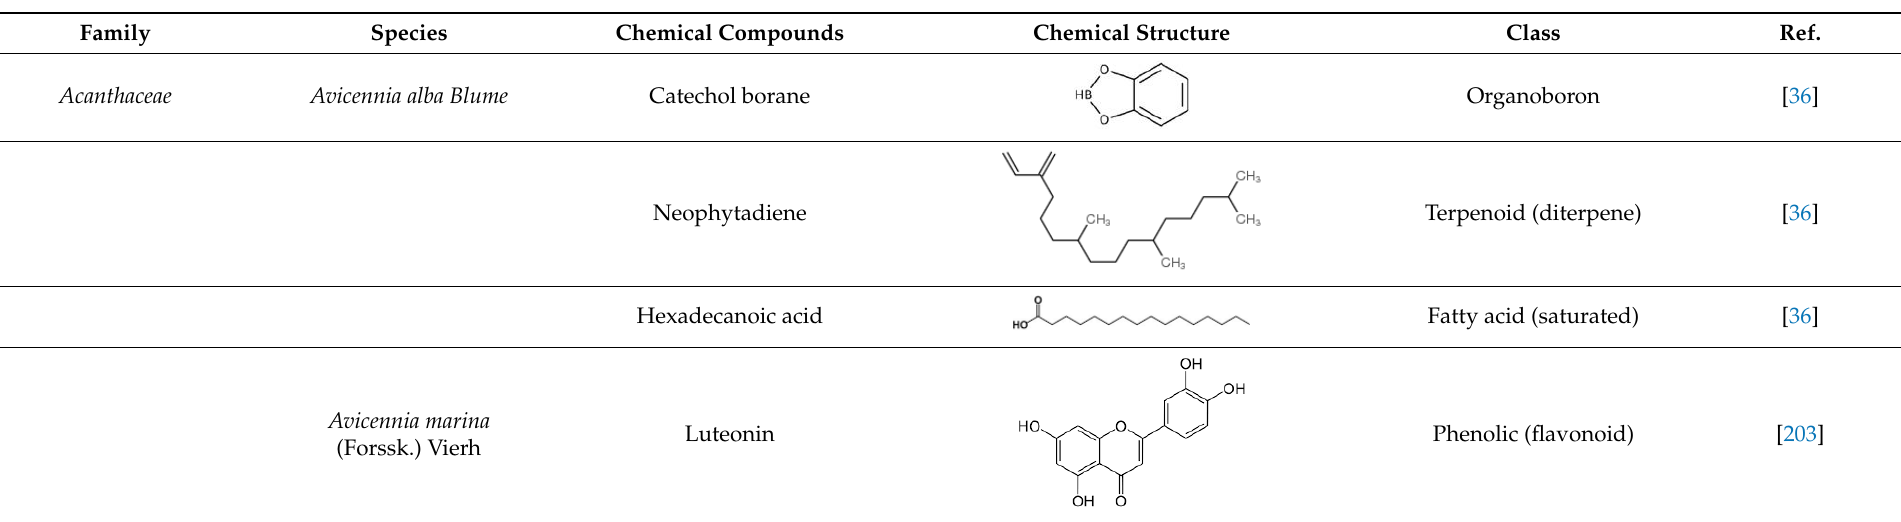
Table 2. Identified molecules in active extracts from halophyte species.